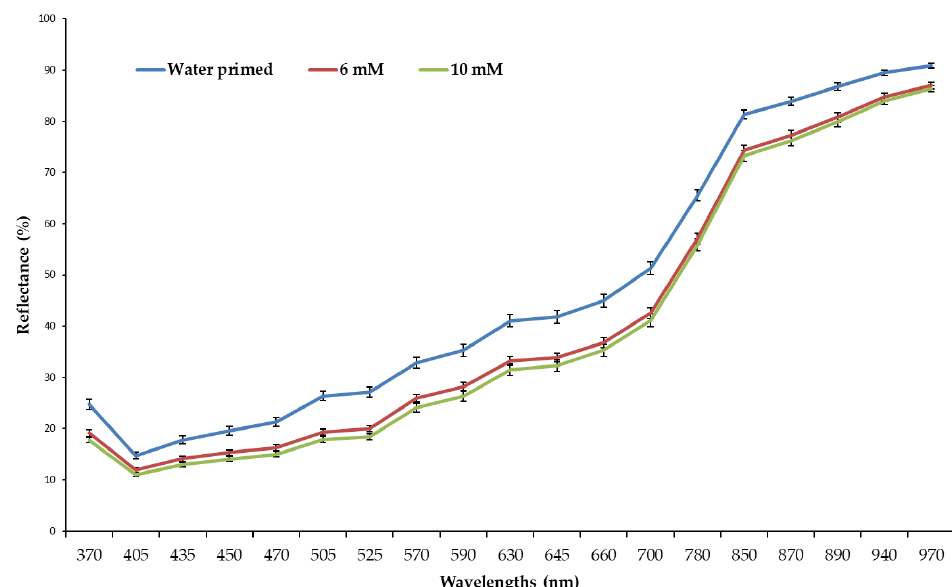
Figure 3. The mean visible spectrum of water-, 6 mM, and 10 mM Zn-primed spinach seeds extracted from the multi-spectral images of seeds at 19 wavelengths (375, 405, 435, 450, 470, 505, 525, 570, 590, 630, 645, 660, 700, 780, 850, 870, 890, 940, and 970 nm). Bars represent the mean and standard error (SE) of four replicates (25 seeds in each replicate).